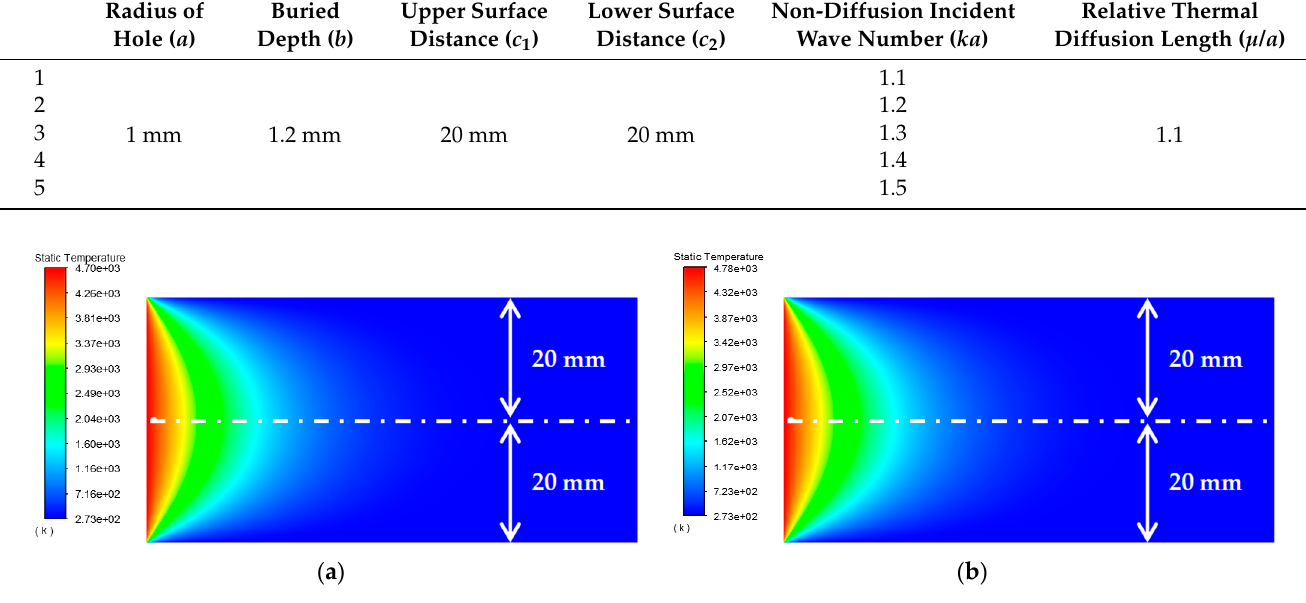
Table 5. Parameters of circular hole and incident light source in the fourtht simulation.